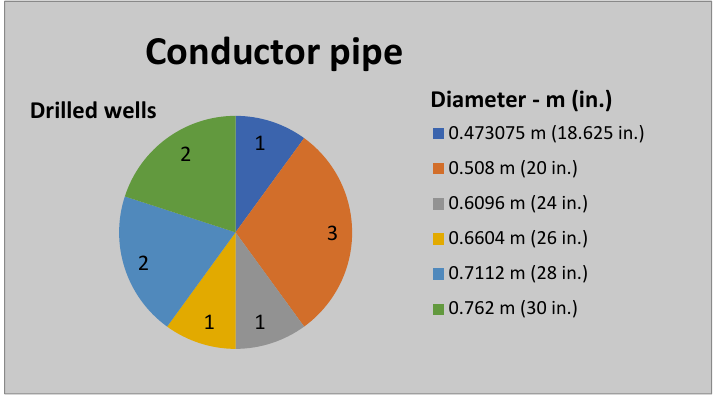
Figure 8. Outside diameter of conductor string installed in 10 analyzed wells.